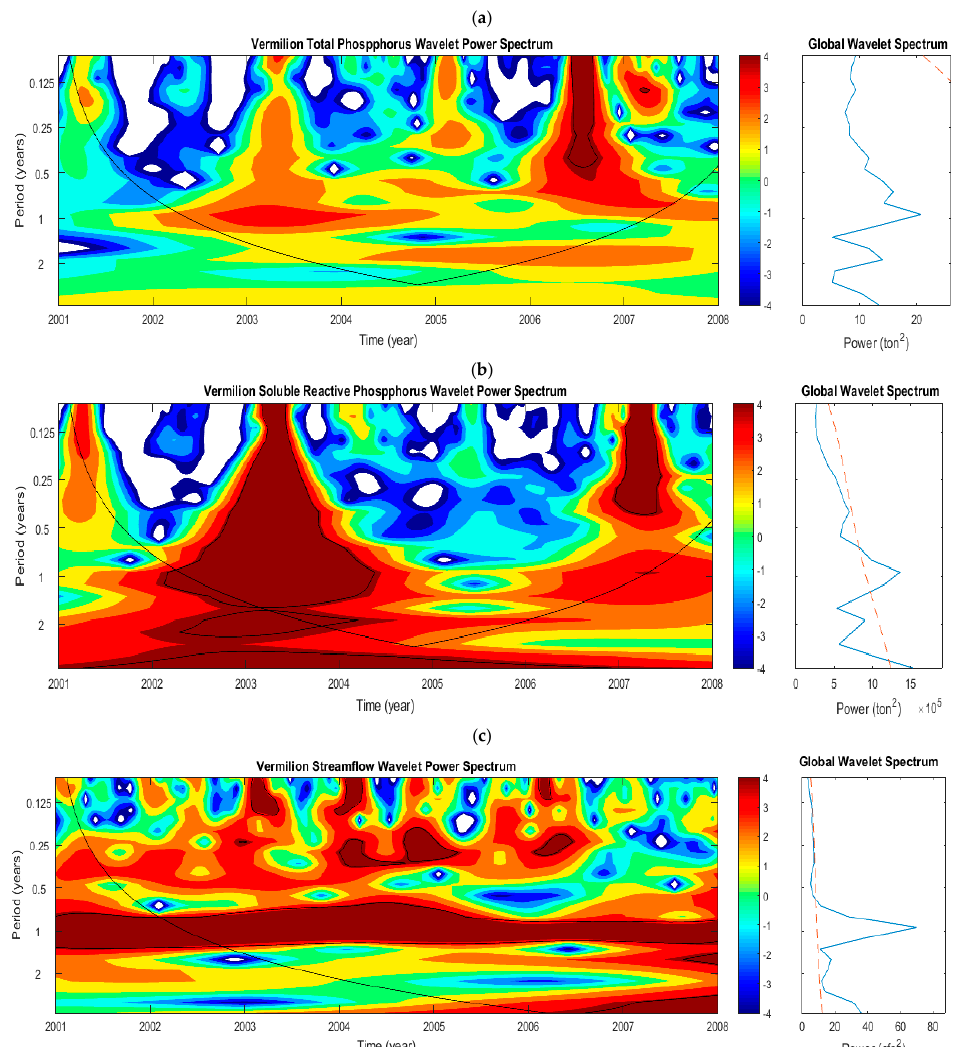
Figure 12. Continuous wavelet power spectrum of ( a ) daily total phosphorus, ( b ) soluble reactive phosphorus, and ( c ) streamflow for the Vermilion River.